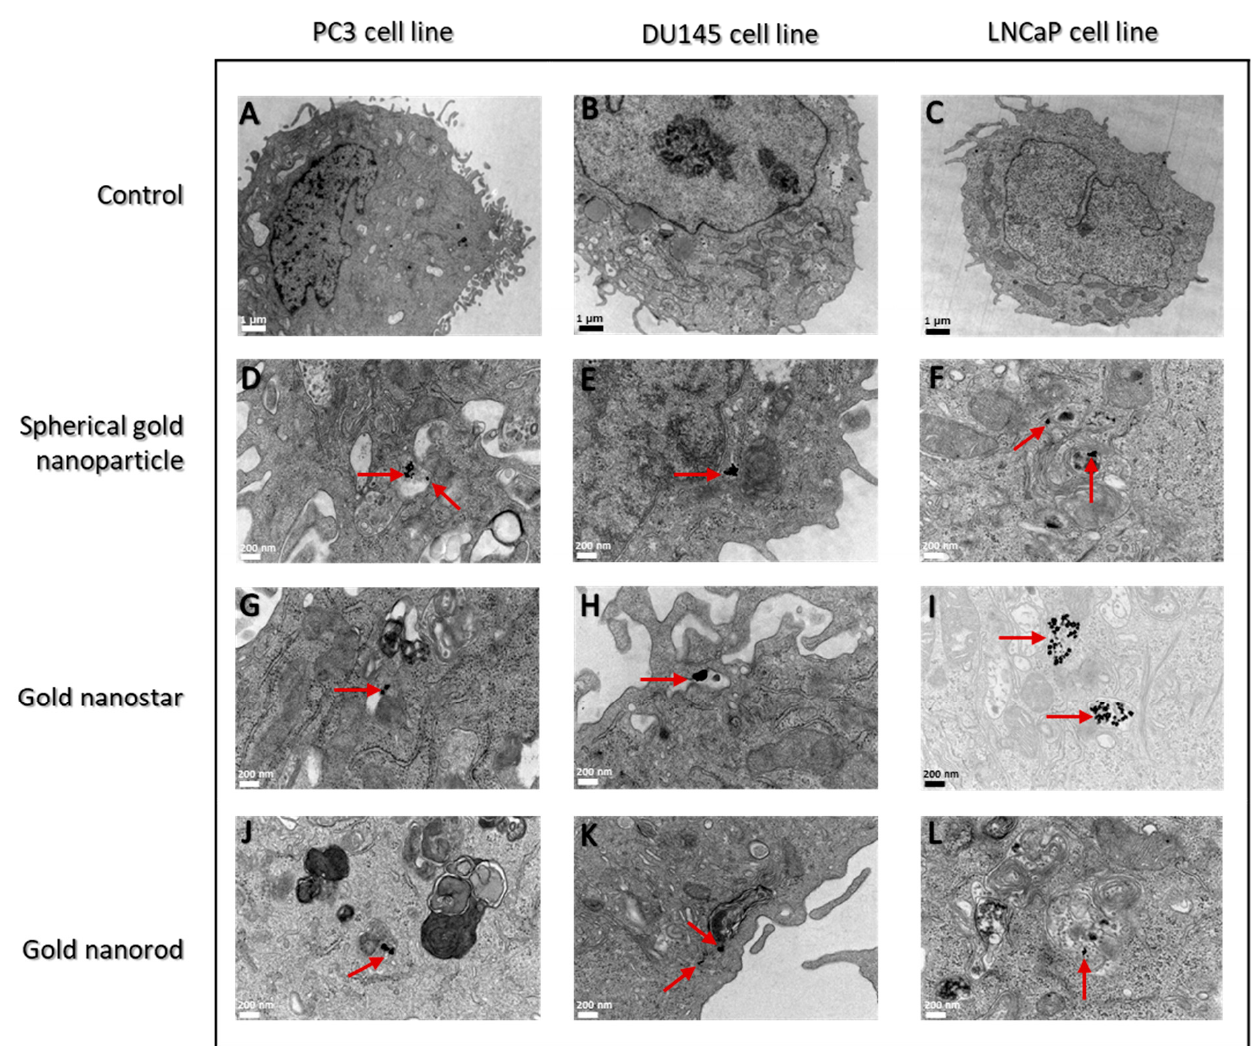
Figure 3. Results of AuNPs-PEG uptake by prostate cancer cell lines (PC3, DU145 and LNCaP) treated with 0.01 mM AuNPs for 24 h. Representative TEM images of ultrathin sections. Red arrows, indicate the presence of AuNPs inside all cell lines. Images of cells without AuNPs-PEG treatment (control, ( A – C )). Cells treated with AuNP sp -PEG ( D – F ); cells treated with AuNP st -PEG ( G – I ); and cells treated with AuNP r -PEG ( J – L ). TEM magnification image 12,000× ( A – C ) and 50,000× ( D – L ). SEM scale bar is 1 µm to control cells and 200 nm for treated cells.